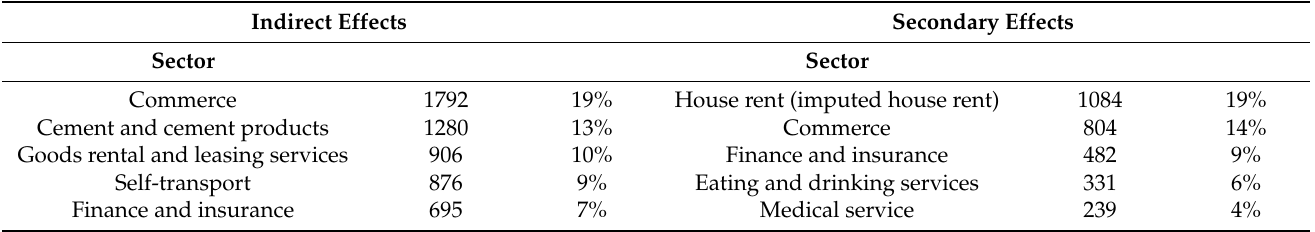
Table 11. Indirect and secondary effects (in thousands of yen) of the construction of a concrete dam and issuing a premium voucher, with percent contribution to production value induced: top five